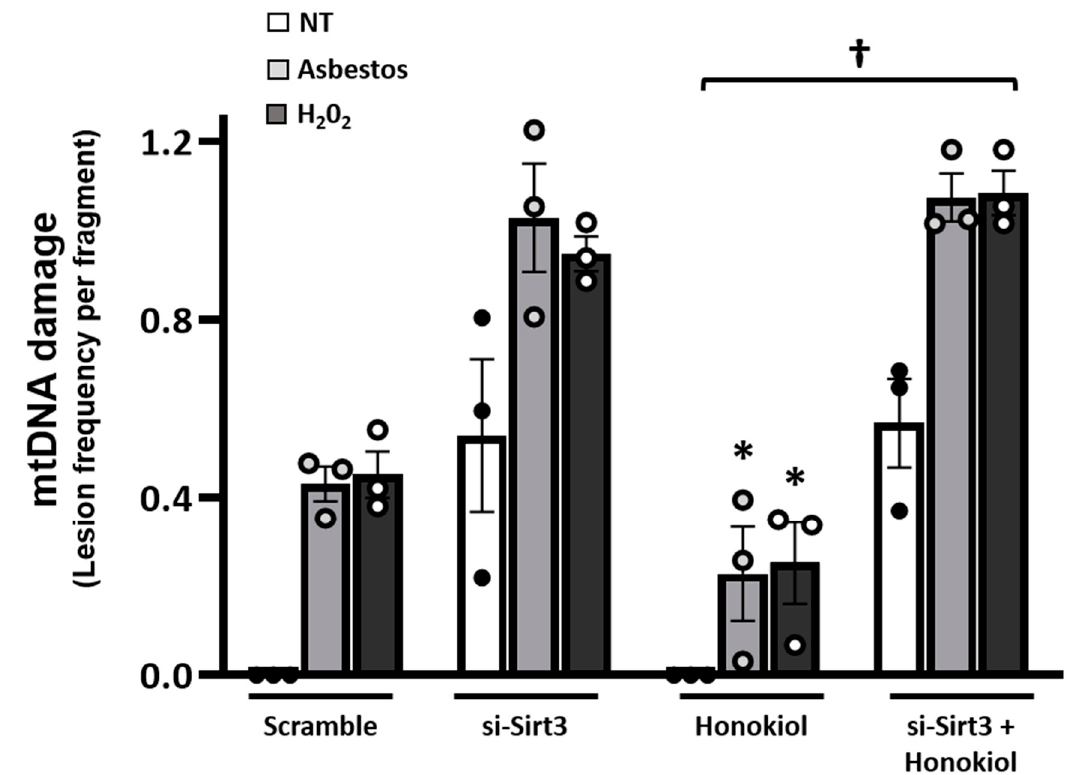
Figure 5. Honokiol, a specific SIRT3 inducer, attenuates MLE-12 cell oxidant-induced mtDNA damage in a SIRT3-dependent manner. Forty-eight hours after transfection with scramble or Sirt3 siRNA, MLE cells were treated for 6 h with 10 µM honokiol, followed by 24-h treatment with amosite asbestos @ 25 µg/cm 2 or 250 µM H 2 O 2 . mtDNA damage expressed as lesion frequency per DNA fragment. All n = 3; * p = 0.07 vs. scramble + Asb or H 2 O 2 ; † p < 0.05 vs. honokiol + Asb, or honokiol + H 2 O 2 .